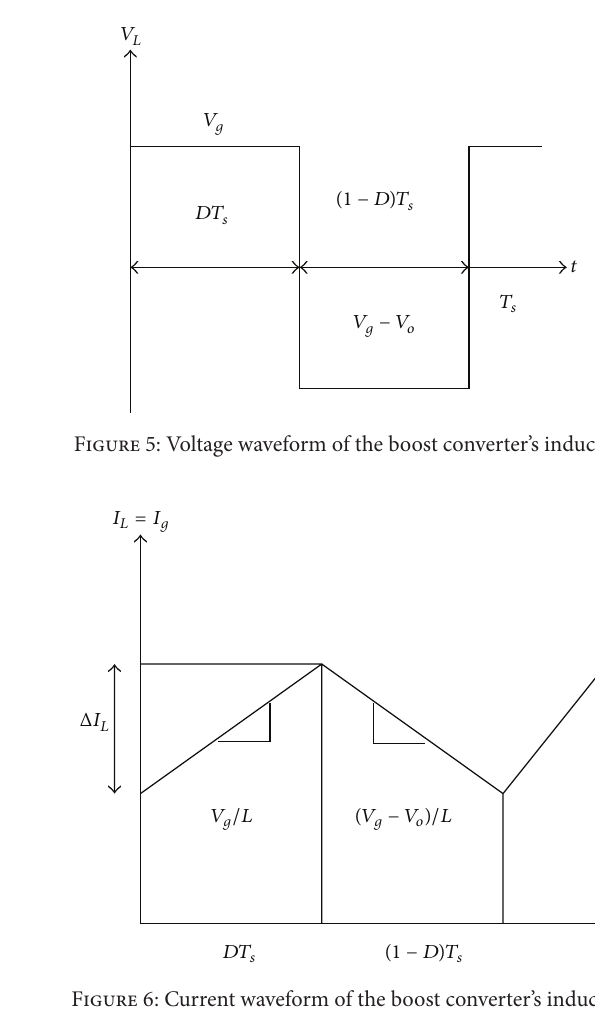
Figure 6: Current waveform of the boost converter’s inductor.